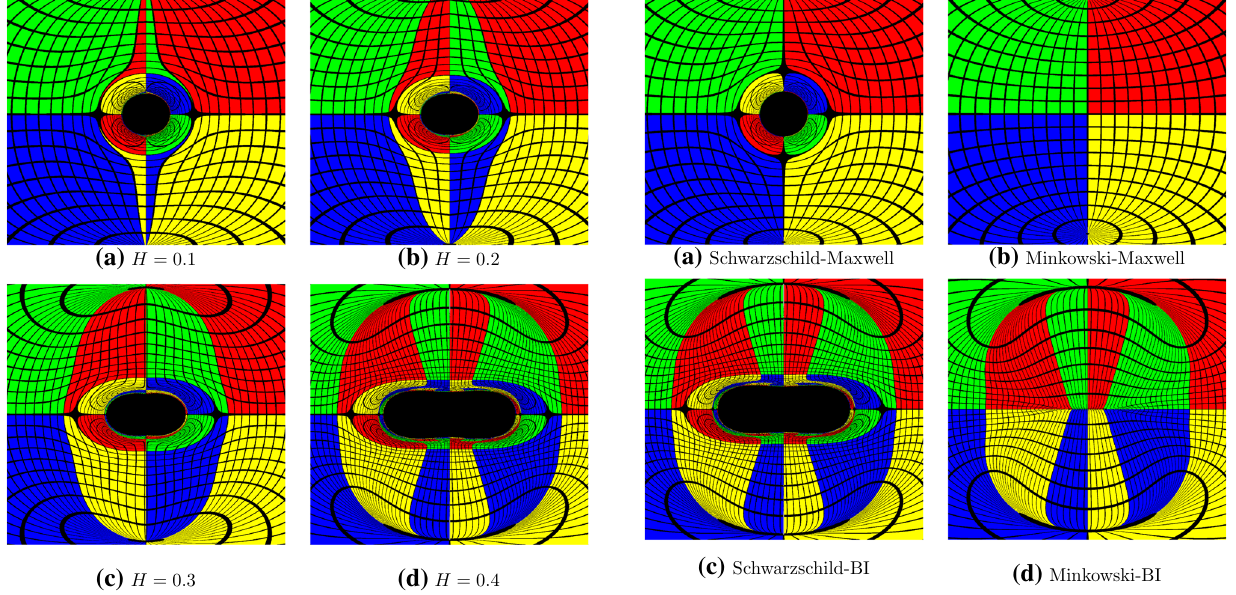
Fig. 4 Images of the Schwarzschild black hole immersed in uniform magnetic fields for different H with the black hole mass m = 1. With H increases, the shadow contour stretches along the equatorial plane to ellipses. While for H = 0 . 3 in Fig. 4c and H = 0 . 4 in Fig. 4d, shadow contours get more severe stretches, showing shapes similar to peanuts.